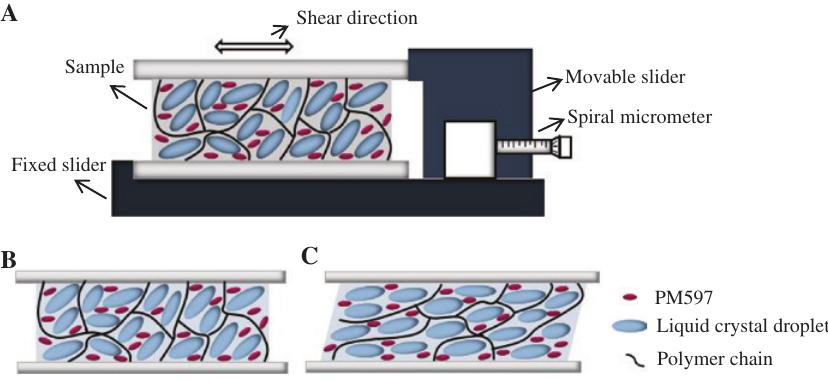
Figure 1: The schematic diagrams of the shearing device and internal structure of the sample. (A) The device for applying shear force to DDPDLC. (B) The internal structure of the sample before being sheared. (C) The internal structure of the sample after being sheared.